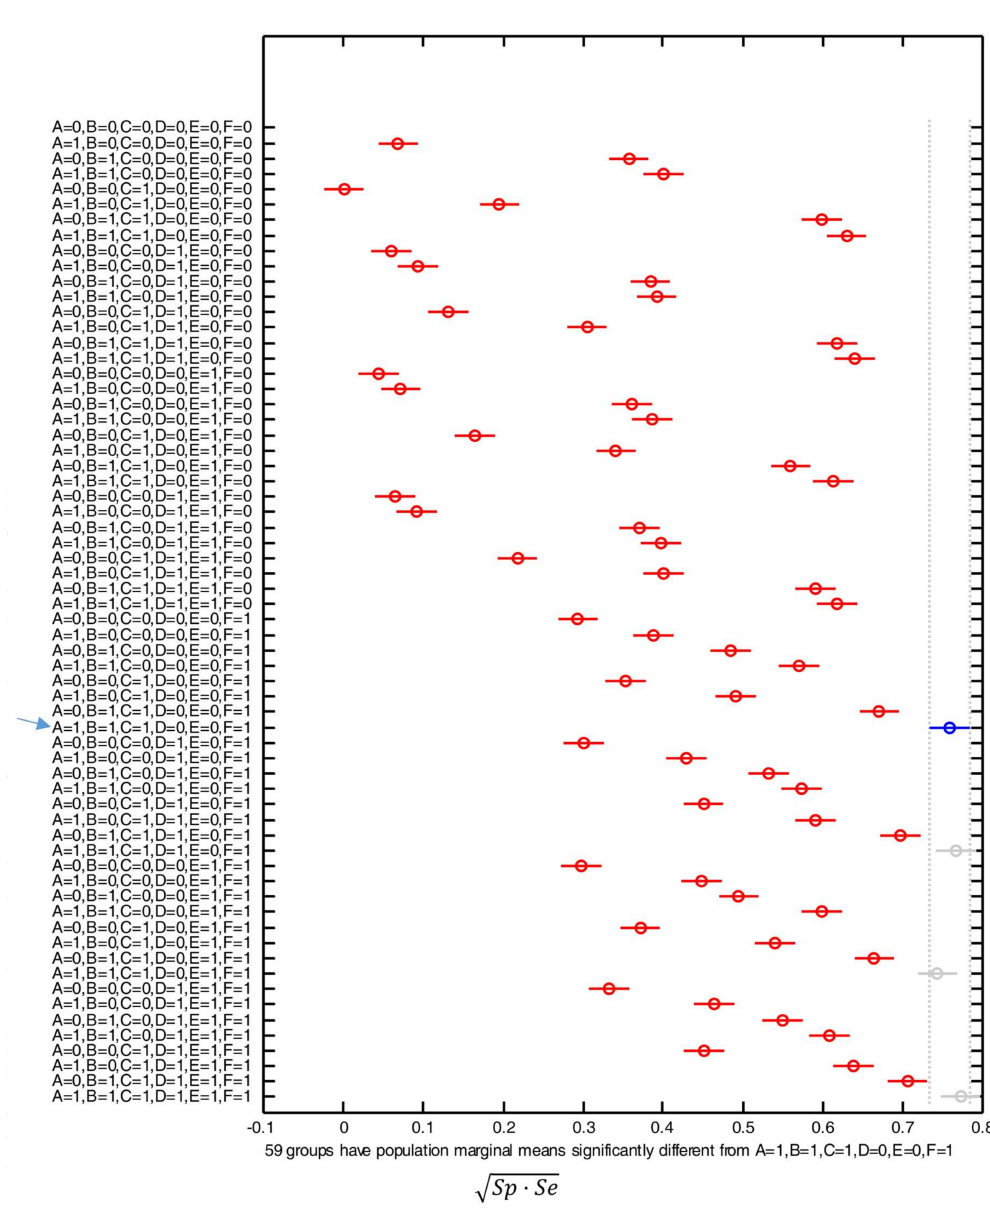
(cid:112) Sp · Se or geometric mean of the Figure 9. Comparison of the means of the performance metric ( sensitivity and the specificity) obtained with the SVM algorithm for all the possible combinations of input features: A = µ SMV , B = A w , C = σ SMV , D = µ θ , E = µ SMV , F = µ Ap . For each combination, diff ( max ) diff the y -axis of the figure indicates with ‘1’ or ‘0’ whether the corresponding feature is considered (‘1’) or not (‘0’). The combination with the best results is indicated with a blue